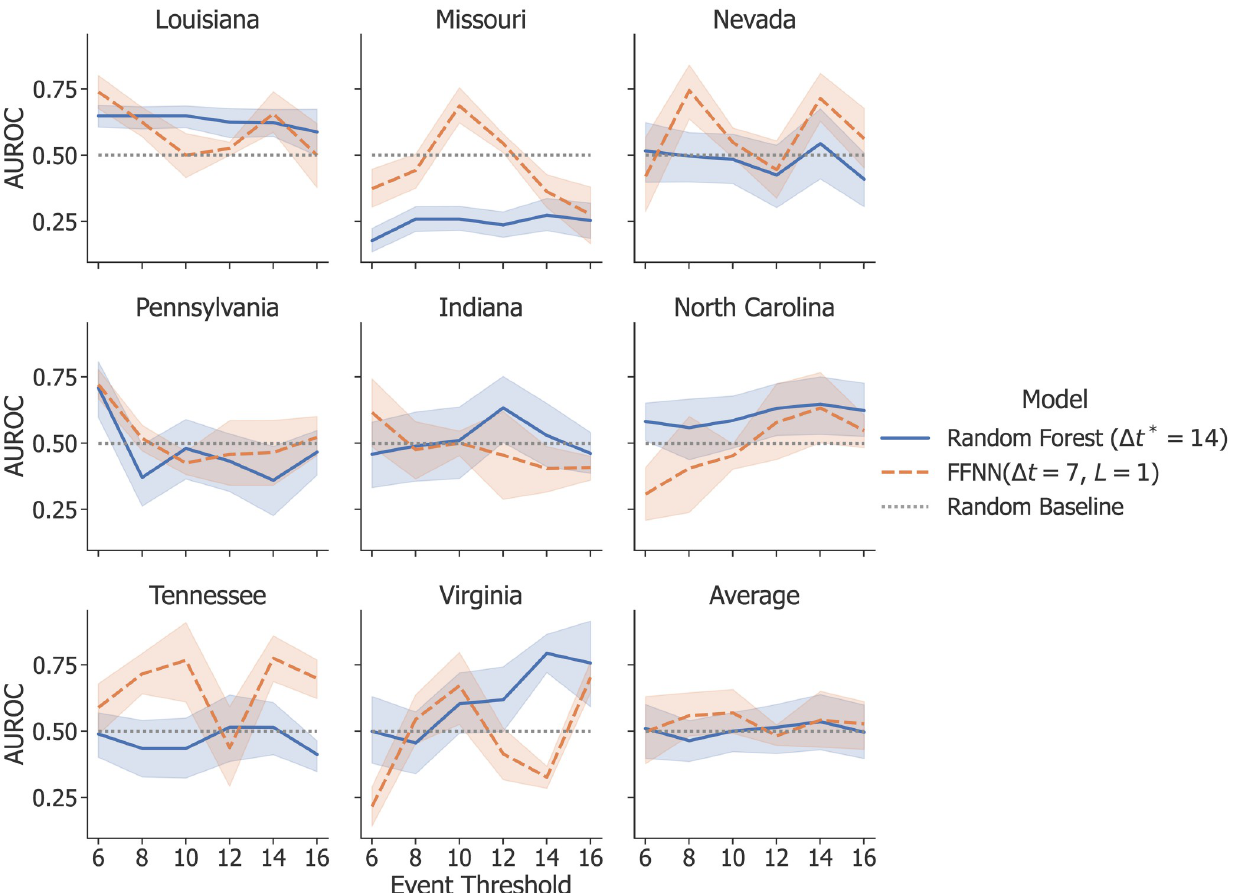
Fig 10. Classification results on additional states. The results on single-state testing show that neither RF nor FFNN perform significantly better than random on states that have experienced 5–7 attacks. Each plot shows AUROC as a function of the event threshold for each cross-validation experiment. The shaded areas represent the standard deviations of testing